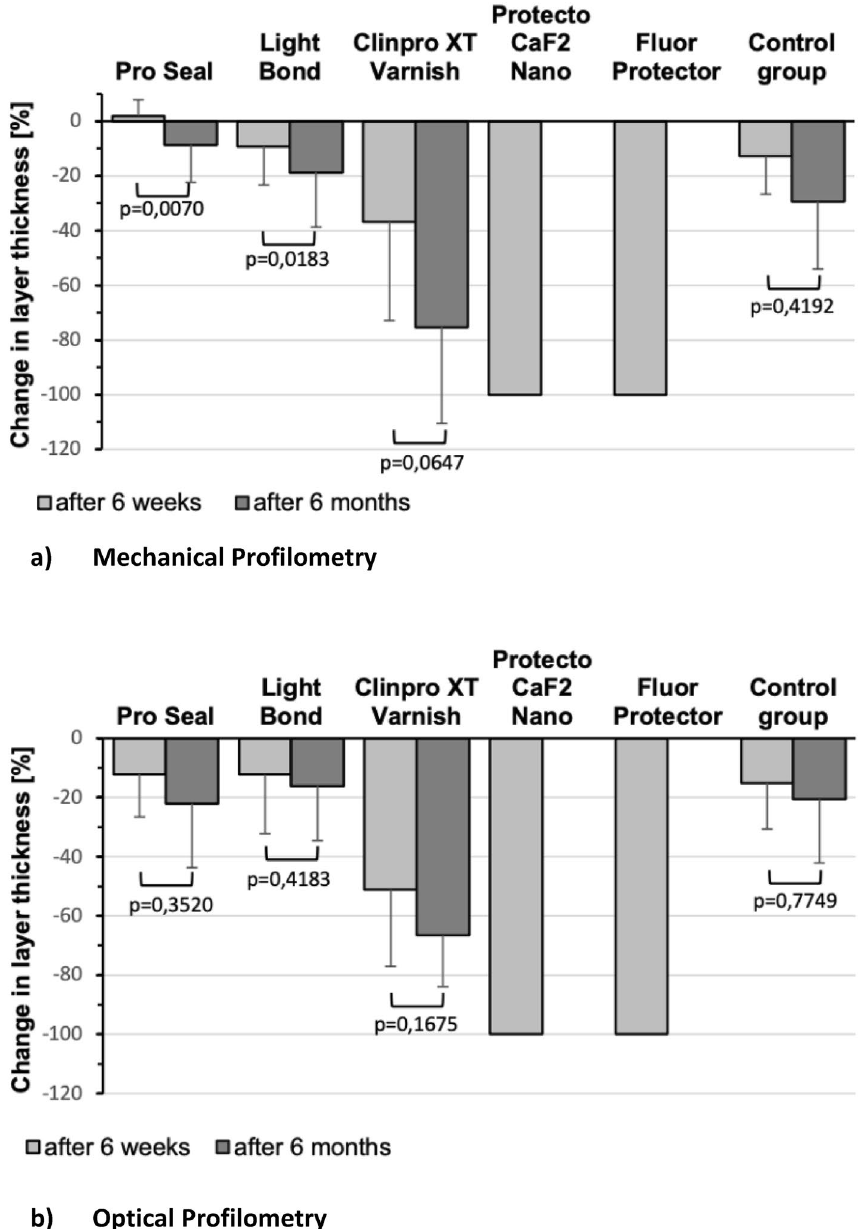
Figure 4. Diagram showing profilometry comparison of all sealants; light grey bars represent the measuring points after 6 weeks; dark grey bars represent 6 months: ( a ) mechanical profilometry, ( b ) optical profilometry. There are no dark grey bars for Protecto CAF2 and Fluor Protector because both were completely removed after 6 weeks, therefore no longer